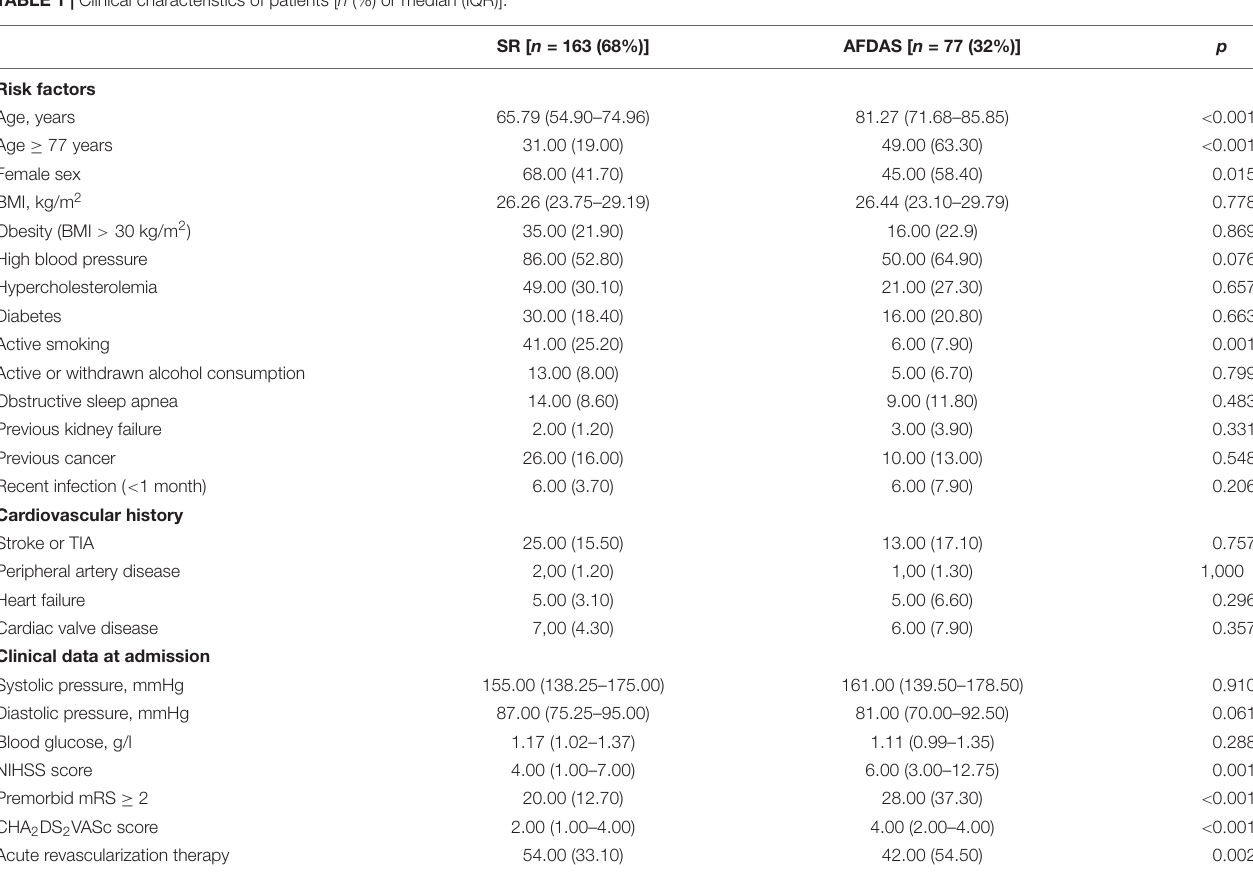
FIGURE 1 | Flow chart of the SAFAS study. TABLE 1 | Clinical characteristics of patients [ n (%) or median